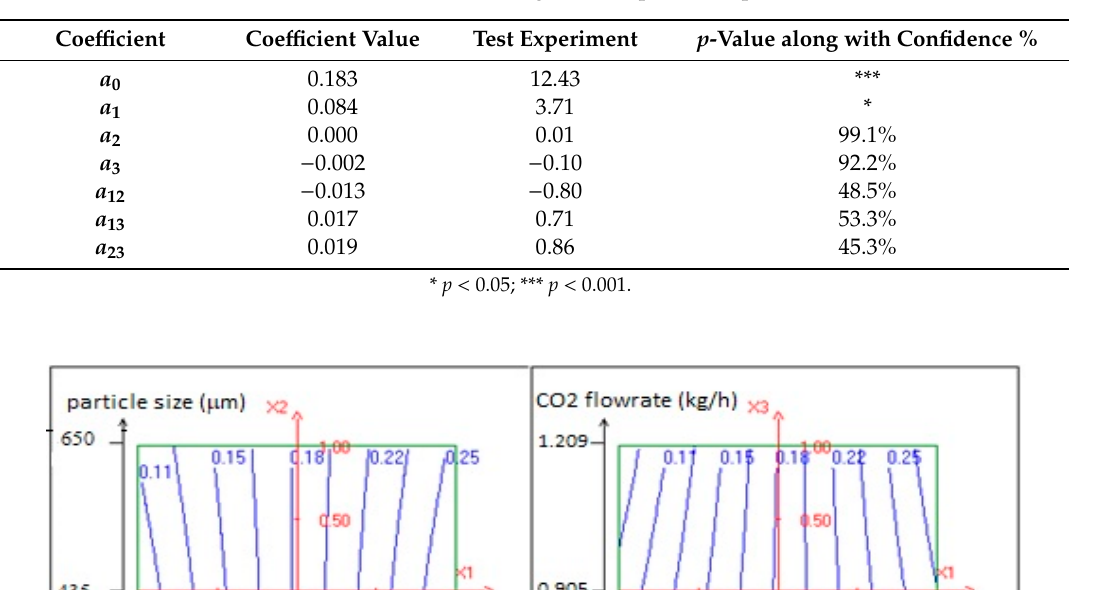
Table 7. Coe ffi cient of a linear regression equation (Equation (1)).